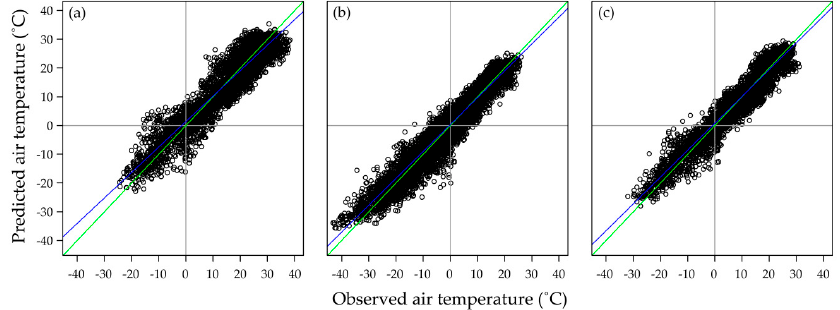
Figure 5. Scatter plots between predicted air temperature (°C) and observed air temperature (°C) of ( a ) T max , ( b ) T min , and ( c ) T mean . The blue line was the relationship between predicted air temperature and observed air temperature, the green line is 1:1 line, which represents the relationship of observed air temperature = predicted air temperature.